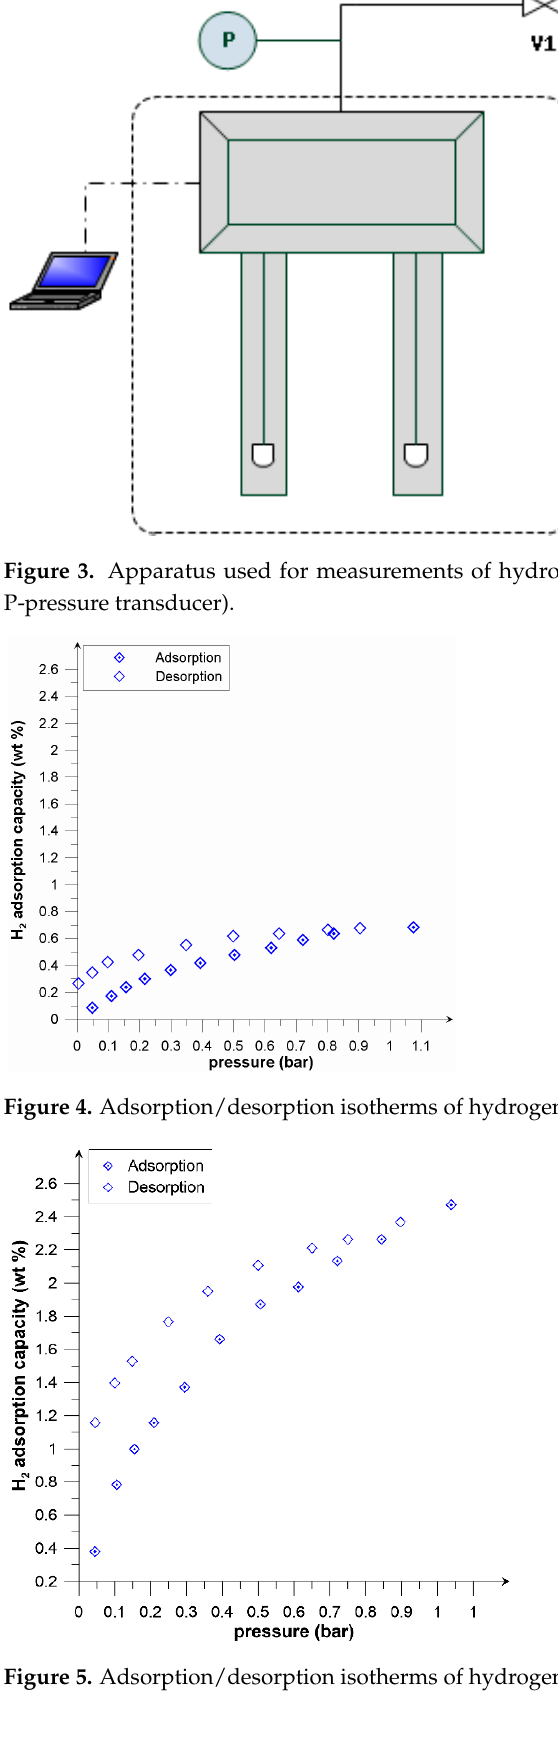
Figure 6. Adsorption/desorption isotherms of hydrogen on Picazine at 300 K. Figure 7. Adsorption/desorption isotherms of hydrogen on Picazine K at 300 K.